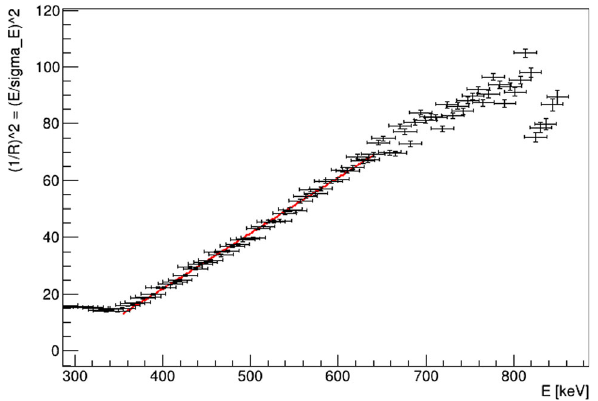
Fig. 25 Trend of the inverse of the square resolution obtained for sev- eral pseudo-photopeaks in the EJ200 calorimeter as a function of the electron energy. In this case, the EJ200 calorimeter is read out by a 1 cm × 1 cm SiPMs